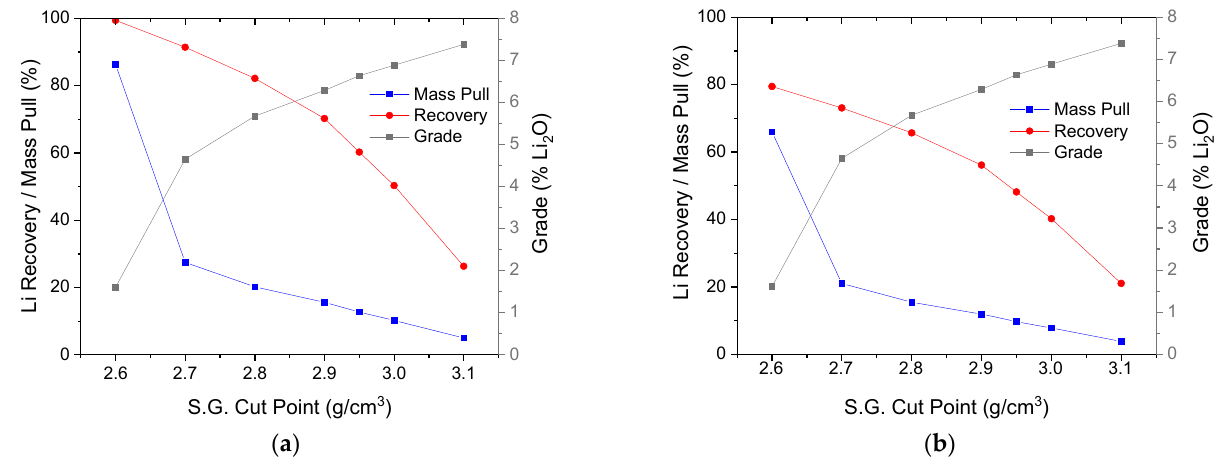
Figure 5. Heavy liquid testing cumulative sink results—( a ) stage recovery and mass pull and ( b ) global recovery and mass pull.